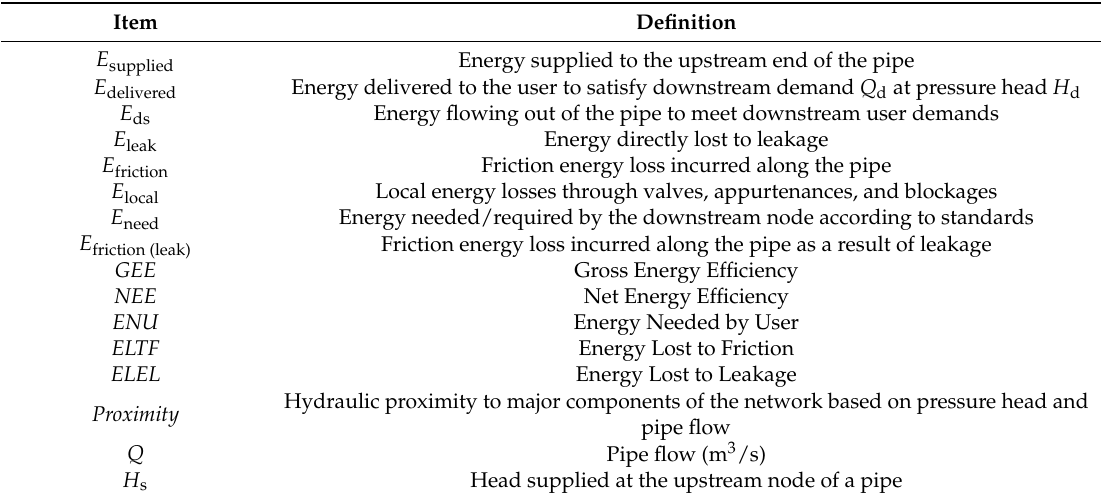
Table 1. Summary of energy components and metrics by